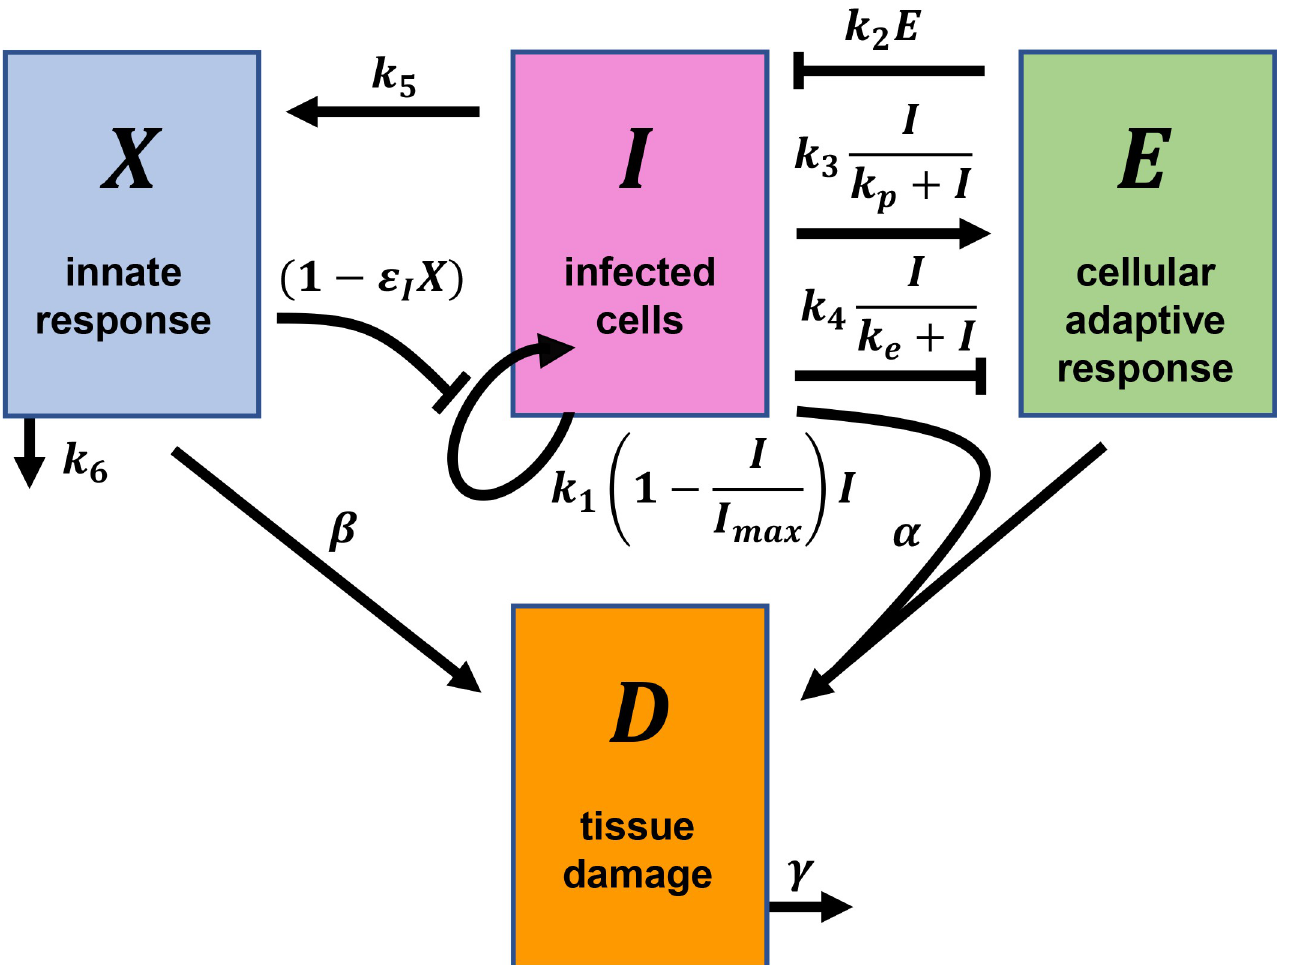
Fig 1. Schematic of the mathematical model of within-host SARS-CoV-2 infection. The key quantities and their interactions contained in our model (Eqs 1– 4) are illustrated. Arrows and blunt-head arrows depict positive and negative regulation, respectively. The parameters and rate expressions shown next to the arrows are described in the